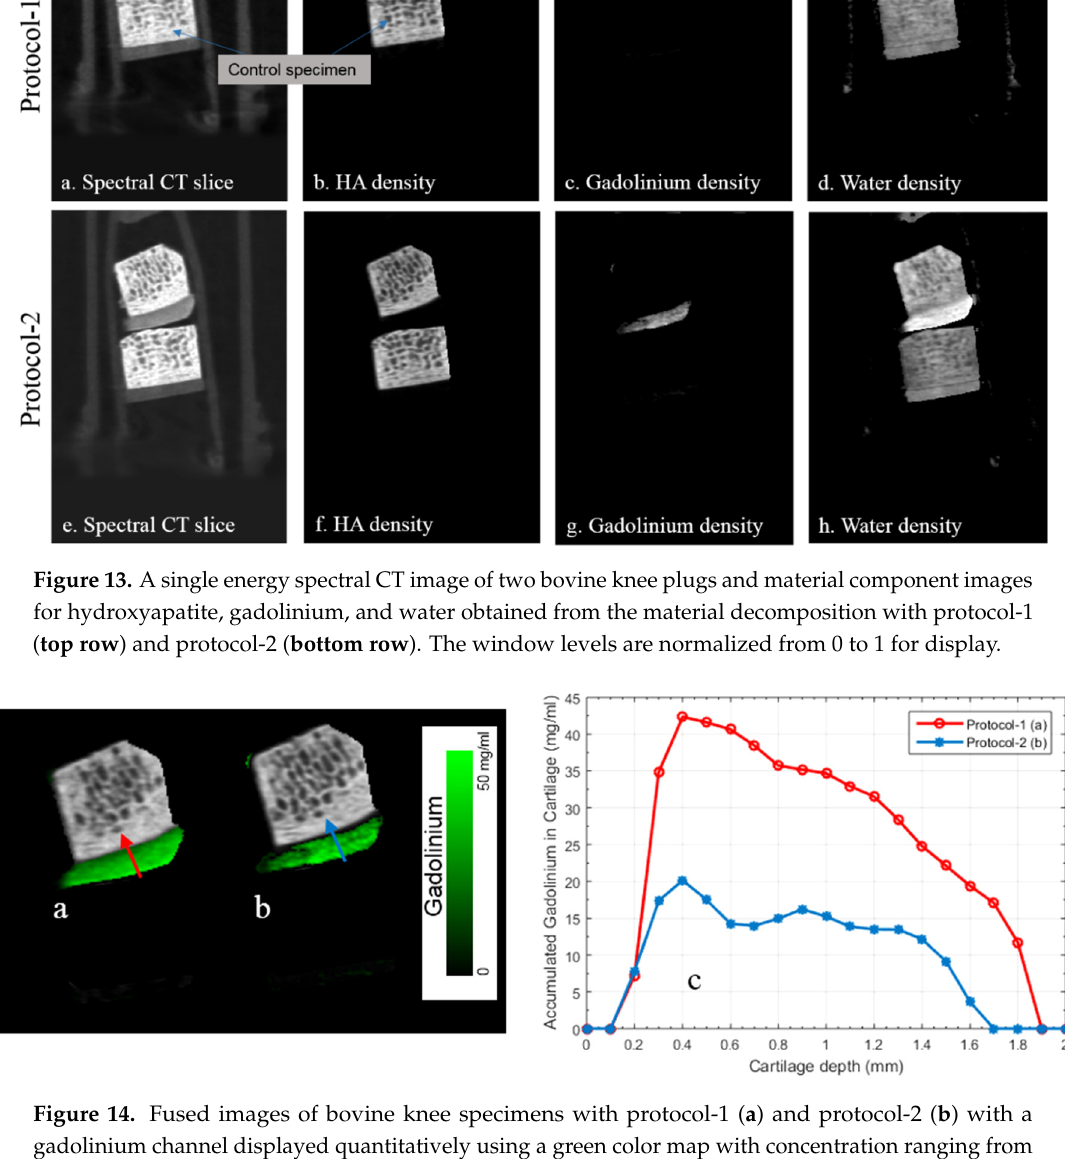
Figure 14. Fused images of bovine knee specimens with protocol ‐ 1 ( a ) and protocol ‐ 2 ( b ) with a gadolinium channel displayed quantitatively using a green color map with concentration ranging from 0 to 50 mg Gd/mL; ( c ) shows a quantified correlation in gadolinium uptake between the two protocols with respect to cartilage thickness (corresponding to arrow directions in ( a , b ). It is evident that despite using the same biological specimen, the two imaging protocols are reporting different